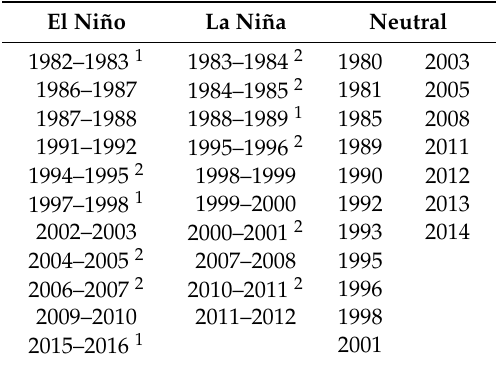
Table 1. El Niño Southern Oscillation (ENSO) phase years between